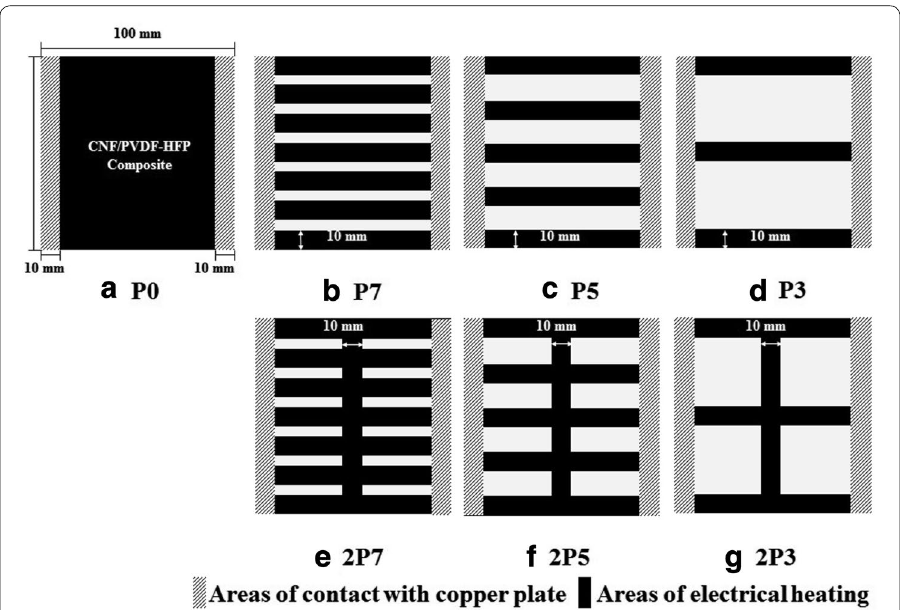
Fig. 1 Design of CNF/PVDF-HFP composite coated on cotton fabrics with various circuit